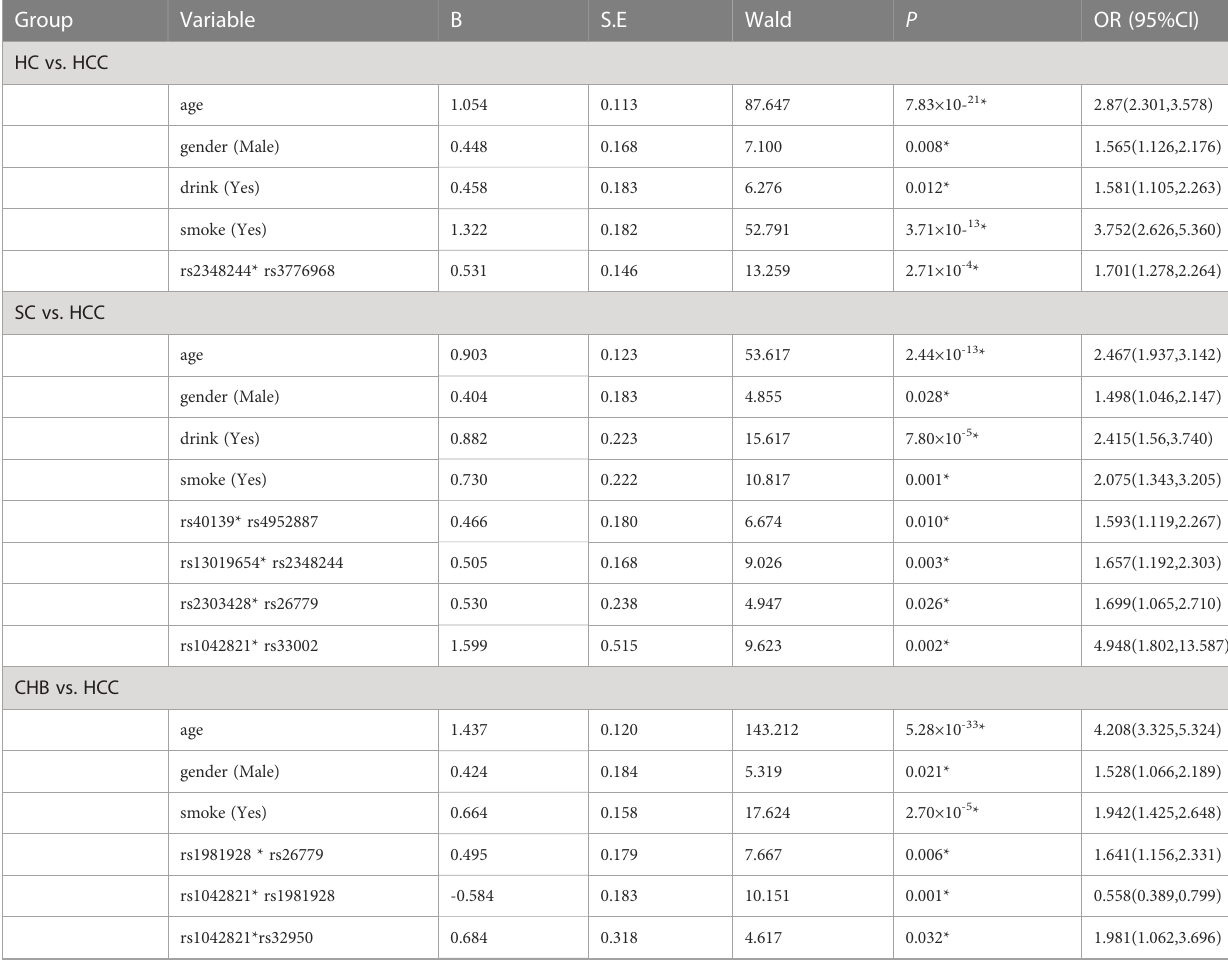
TABLE 4 Multiplicative interaction analysis of SNPs in HC vs. HCC, SC vs. HCC, CHB vs. HCC, LC vs. HCC groups by logistic regression. Group